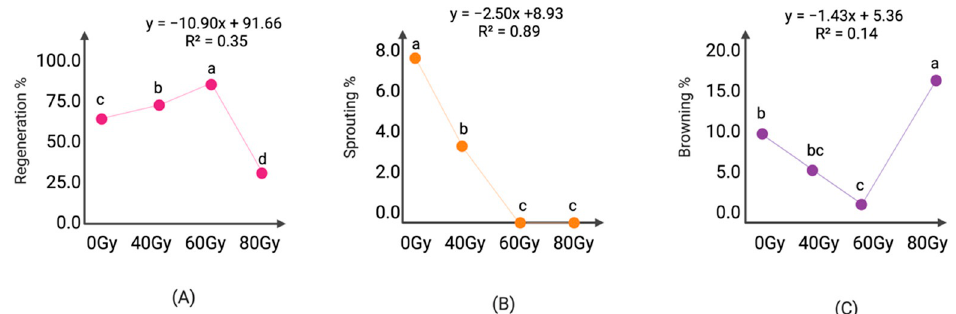
Figure 3. Correlation comparison of radiation dose influence on regeneration ( A ), sprouting ( B ) and browning rates ( C ) of calli of Lazarroz Fl cultivar, after 30 days of culture on regeneration